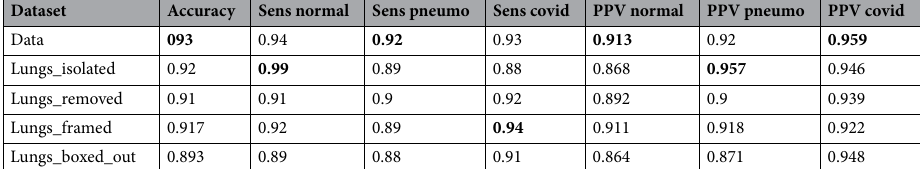
Table 6. Performance metrics using different data preparation strategies classified with pre-trained VGG-11 model. Bold values correspond to best performance metric for dataset in the same row.